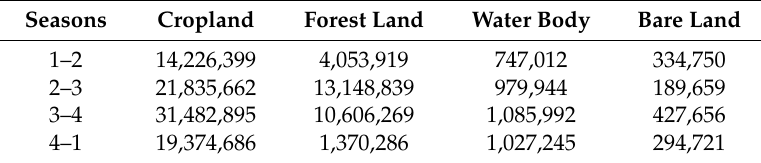
Table 10. Illogical pixels associated with four land cover types for the modified maps. Seasons